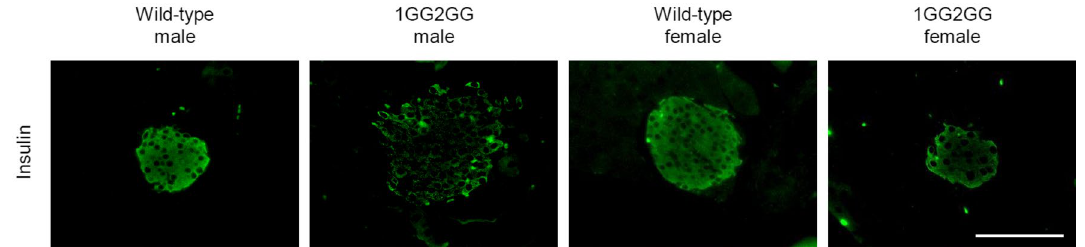
Figure 3. Immunohistochemistry. Immunohistochemical analysis of pancreatic islets (insulin) in wild-type and 1GG2GG mice. Scale bars = 100 µm.